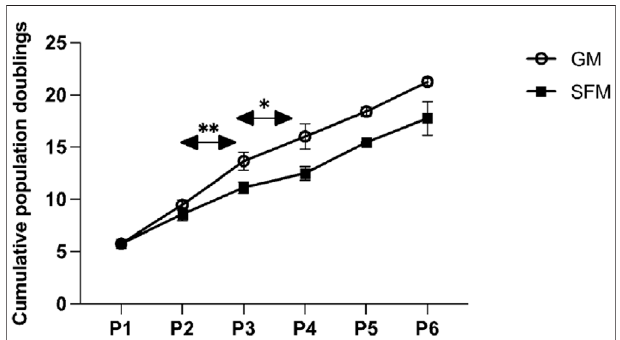
FIGURE 6 | Multi-passage assay oftwo different donors indicated (each in duplicates) in SFM and GM. The line graph shows the means of the cumulative population doublings over the number of passages for GM and SFM. The error bars indicate standard deviations. Asterisks indicate signi fi cant differences of population doublings per passage between the two conditions. At P1 the number of population doublings is > 0 due to the short pre-expansion of cells after their isolation and prior to their freezing in liquid nitrogen.